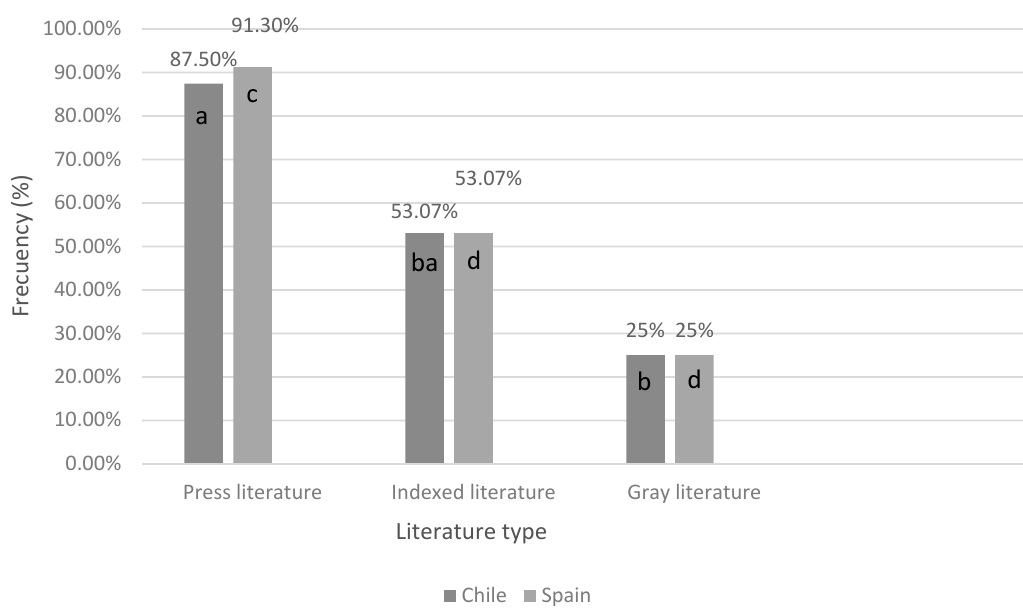
Figure 2. Frequency of records that report potentially dangerous dog bites in the different types of literature in Chile and Spain. The letters a and b refer to statistically significant differences in Chilean literature, and the letters c and d, statistically significant differences between Spanish literatures.